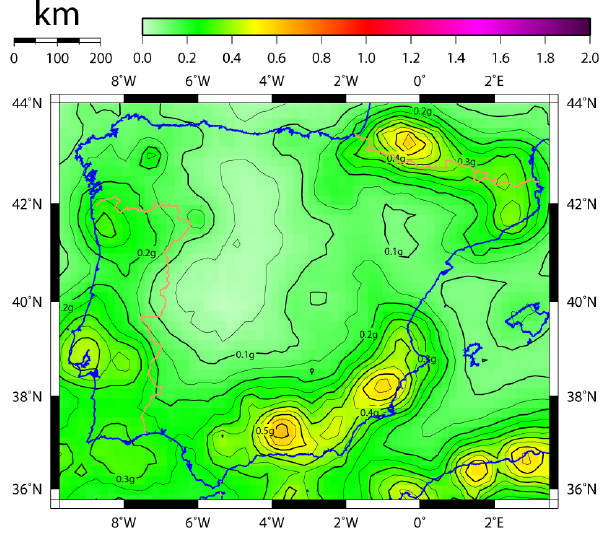
Figure 10. Distribution of the accelerations obtained for T = 0s and 2475yr return